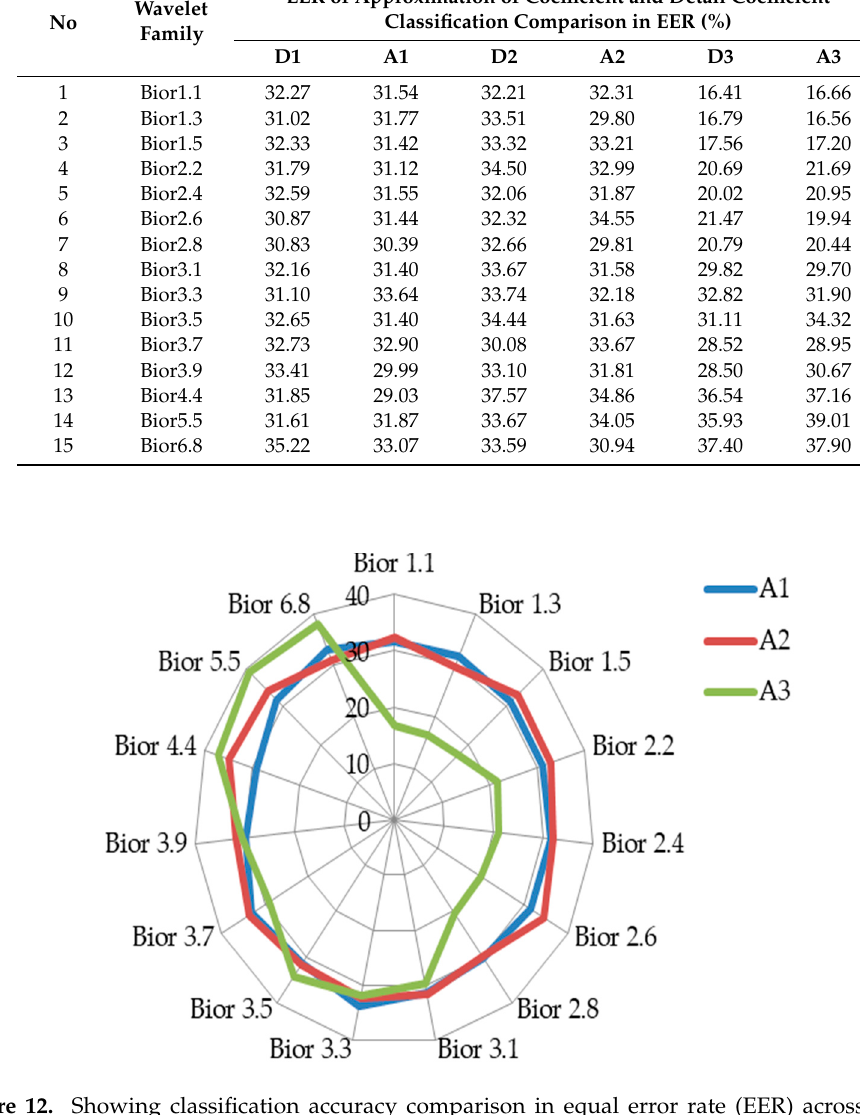
Figure 12. Showing classification accuracy comparison in equal error rate (EER) across various biorthogonal decomposition of approximation of coe ffi cient features (A1: approximation of coe ffi cient biorthogonal decomposition of approximation of coefficient features (A1: approximation of sub-band1; A2: approximation of coe ffi cient sub-band 2; A3: approximation of coe ffi cient coefficient sub-band1; A2: approximation of coefficient sub-band 2; A3: approximation of coefficient sub-b).